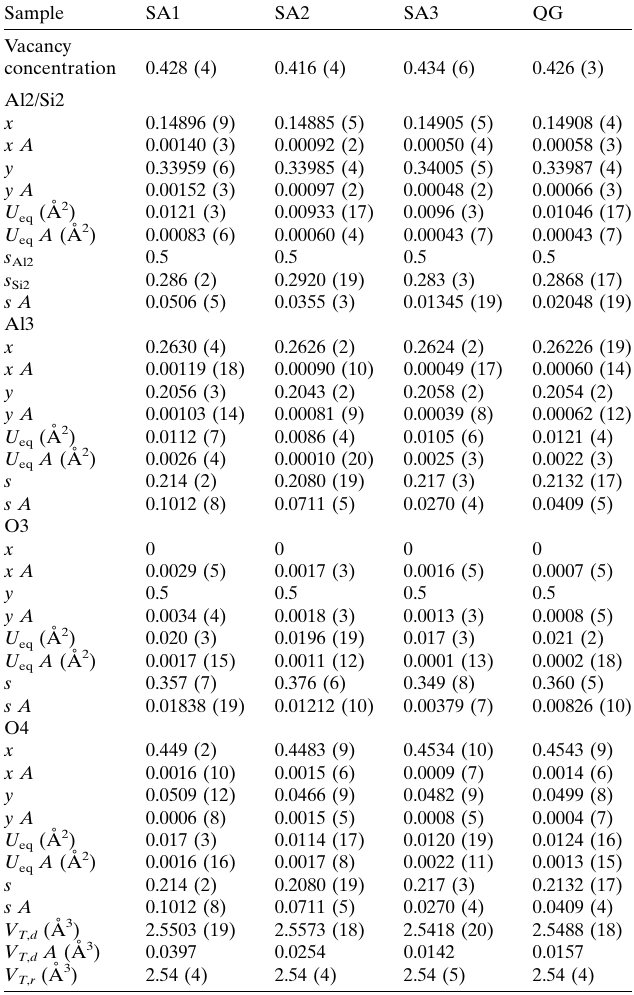
Table 4 Selected parameters of the models from the constrained refinements.